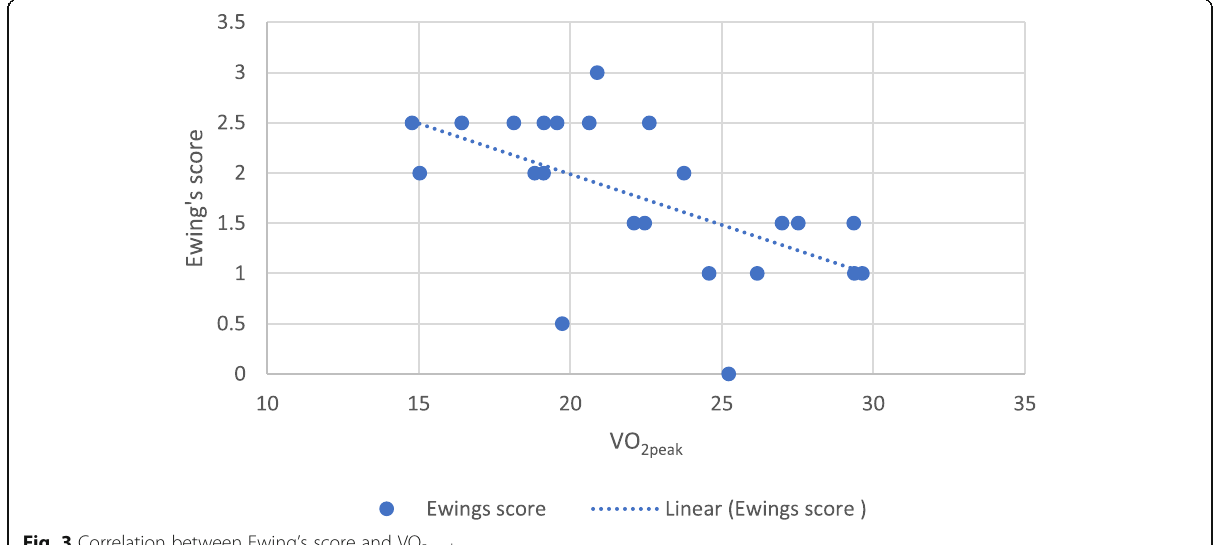
Fig. 3 Correlation between Ewing ’ s score and VO